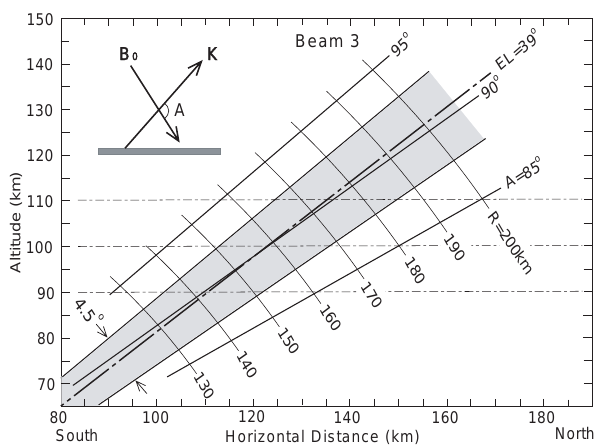
Fig. 2. Configuration of beam 3 in the geographical meridian plane that looks due north with an elevation angle of 39 ◦ . The two-way beam width is 4.5 ◦ (shaded) and 2.3 ◦ in the vertical and horizontal planes, respectively. Contours of the geomagnetic aspect angle ( A ) between the radar wave vector ( k ) and the geomagnetic field vector ( B 0 ) are also shown, together with slant ranges from the MU radar.